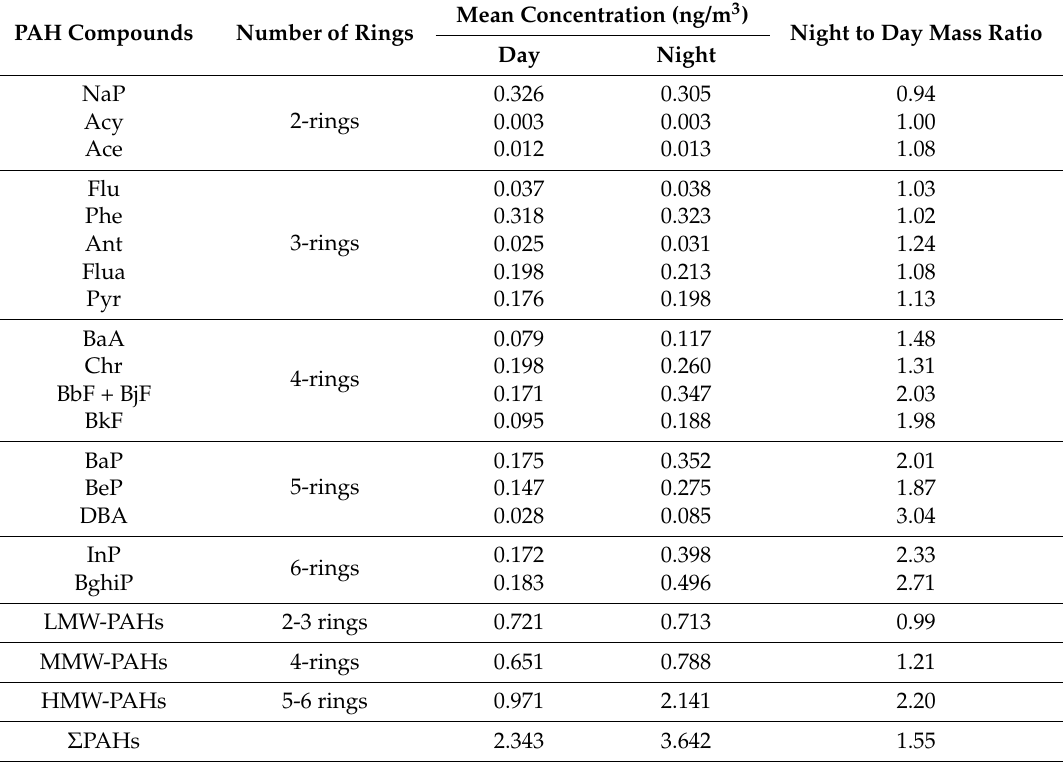
Table 3. Mean mass concentration of individual PAH during day and night as well as night to day mass